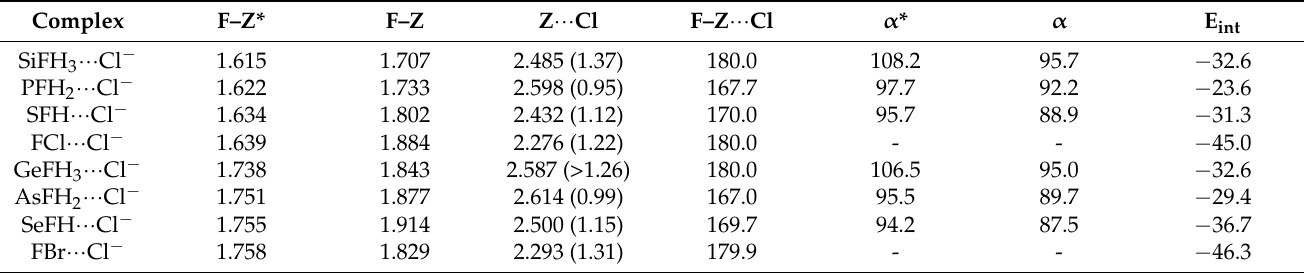
Scheme 1. Definition of the α * and α angles for the isolated Lewis acid unit and for the complex; examples of the SiFH 3 unit and of the SiFH 3 ··· Cl − complex are presented. Table 1. Interaction energy (in kcal/mol) and the geometrical parameters (in Å, lengths, and degrees, angles) of the complexes analysed here. The α * and α angles are defined in Scheme 1; the F–Z ··· Cl angle concerns the intermolecular contact. Z ··· Cl is the intermolecular distance, the difference between the sum of the corresponding van der Waals radii (the Bondi radii, ref. [53], were applied here), and this Z ··· Cl distance is given in parentheses. The F–Z bond length and its corresponding length of the isolated Lewis acid unit, F–Z*, are also given. Z ··· Cl distances and E int energies were also presented earlier in another study (ref.17).